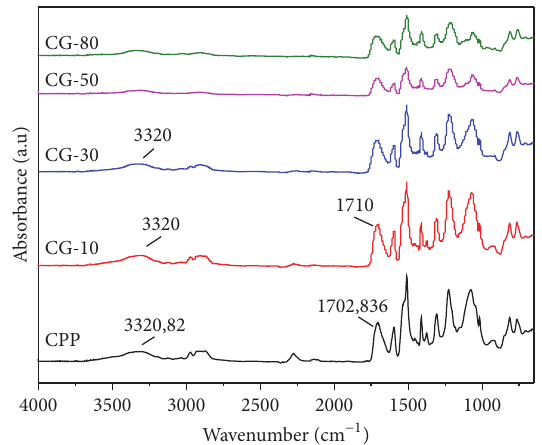
Figure 1: FTIR results of PUF samples with crude glycerol.